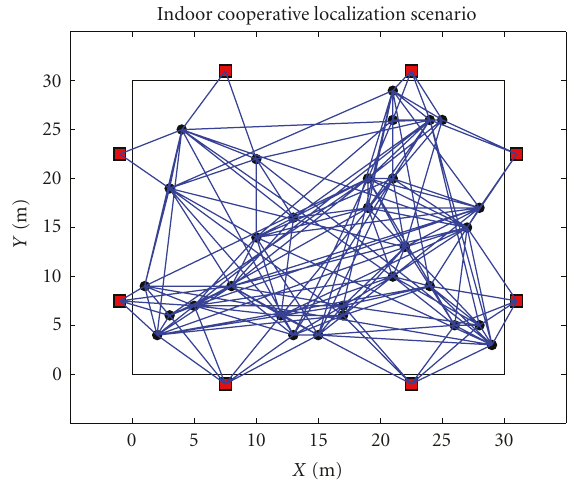
Figure 1: Indoor cooperative localization application. Squares are anchor nodes and circles are sensor nodes. Connectivity based on Fuller models at 500